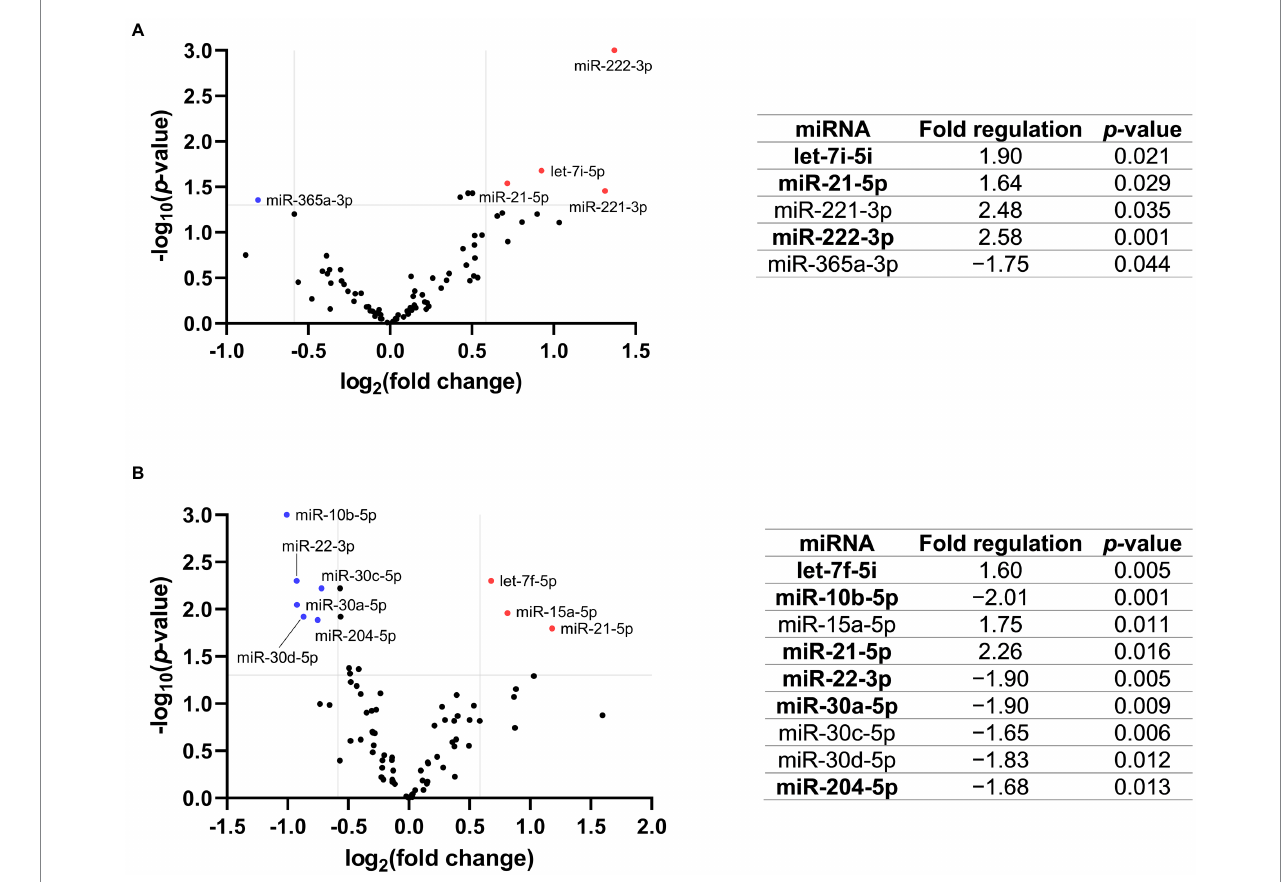
FIGURE 1 Volcano plot with the corresponding table showing the comparison of miRNA expression of Fabry patients with (A) stable renal function ( n = 5) or (B) progressive nephropathy ( n = 5) with the corresponding control group ( n = 5). The blue dot indicates downregulated and the red dots indicate upregulated miRNAs. The grey lines represent the cut-off criteria for significant regulation. Only miRNAs with a fold change >1.5 and a p- value <0.05 are listed in the table. The miRNAs marked in bold were selected for